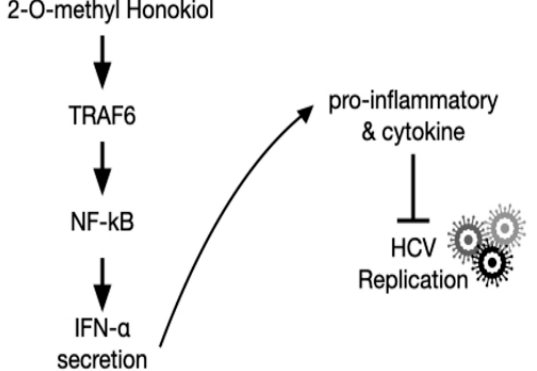
Figure 7. Schematic of the mechanism by which 2-O-methylhonokiol suppresses HCV replication.